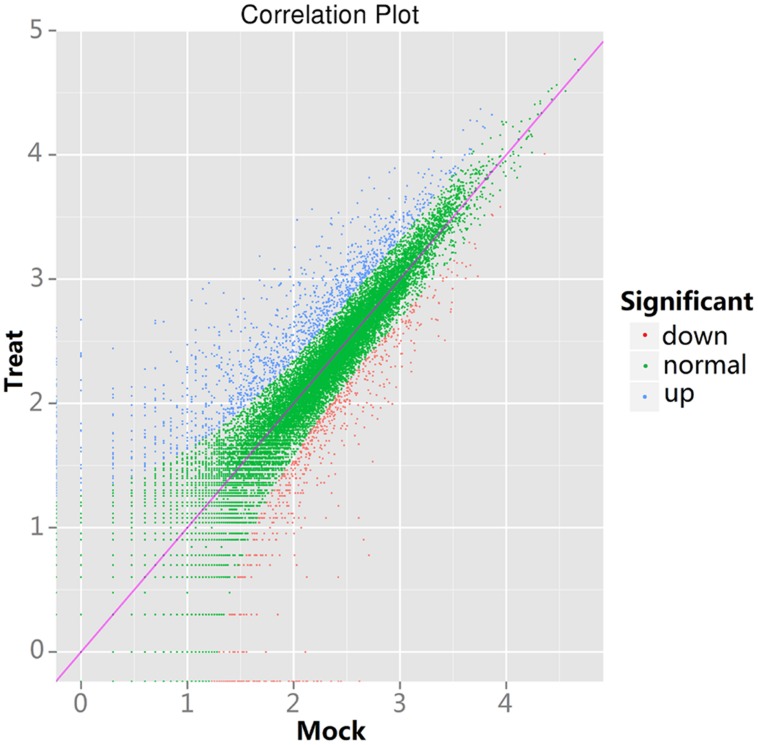
Scatter plots of differentially expressed genes (DEGs) between control and treatment tomatoes. The y-axis shows the expression level of treatment tomatoes and the x-axis is the expression level of control tomatoes.